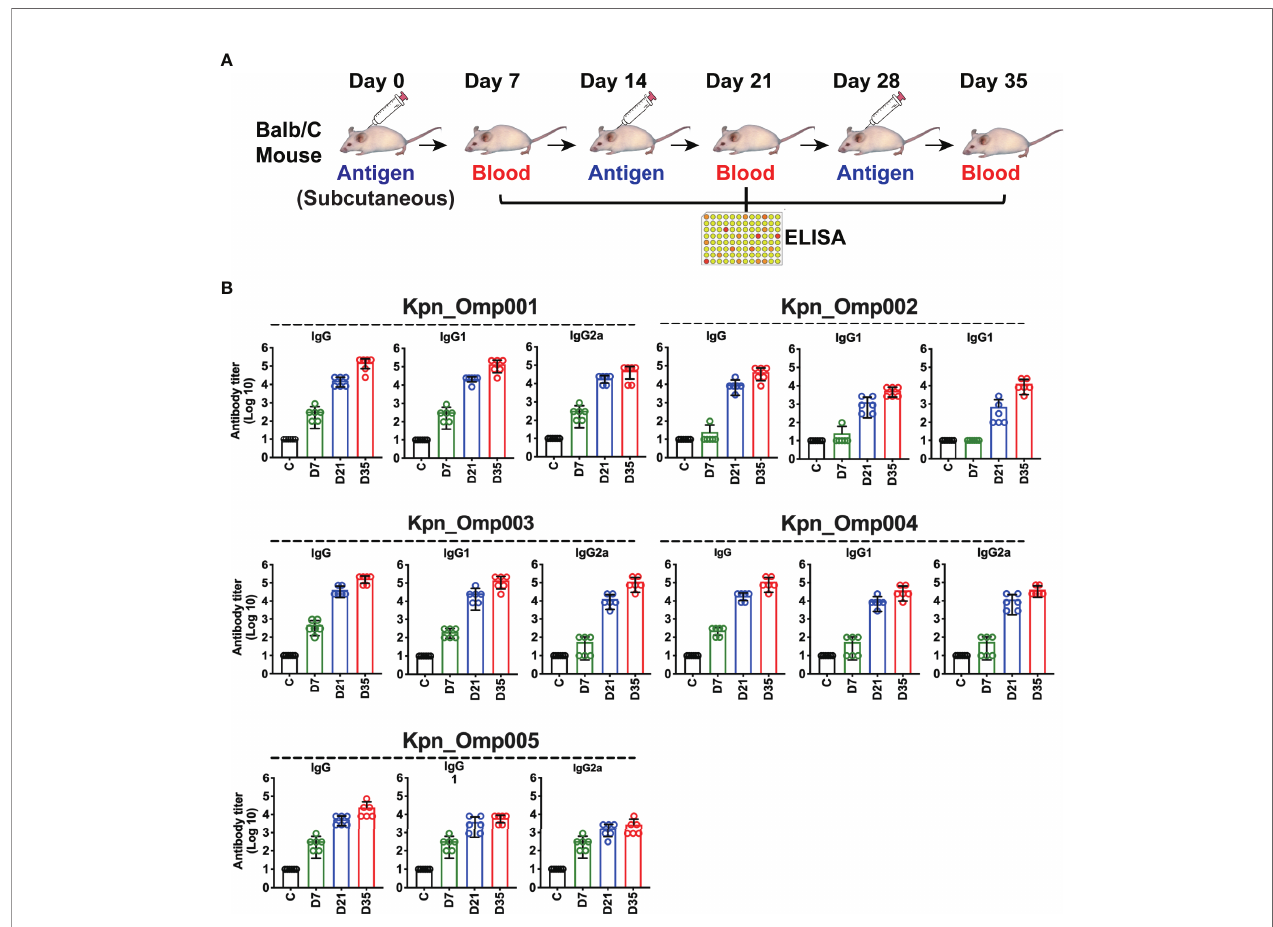
FIGURE 2 | Speci fi c antibody responses in immunized mice. (A) Balb/c mice were immunized with the fi ve KOMPs individually or PBS, and antibody titers were determined by enzyme-linked immunosorbent assay (ELISA). (B) Speci fi c IgG/IgG1/IgG2a antibody responses in mouse sera were collected at 7 days after the third vaccination of the fi ve KOMPs. The experiment was repeated at least